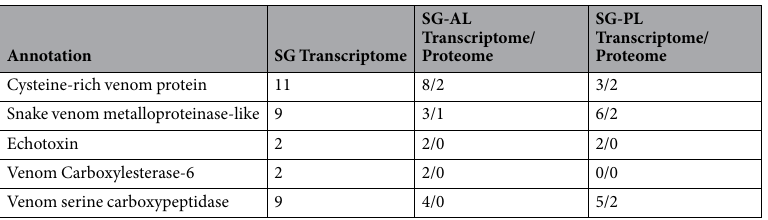
Table 2. Identification of putative toxin-related proteins from the Charonia tritonis salivary gland (SG) anterior lobe (AL) and posterior lobe